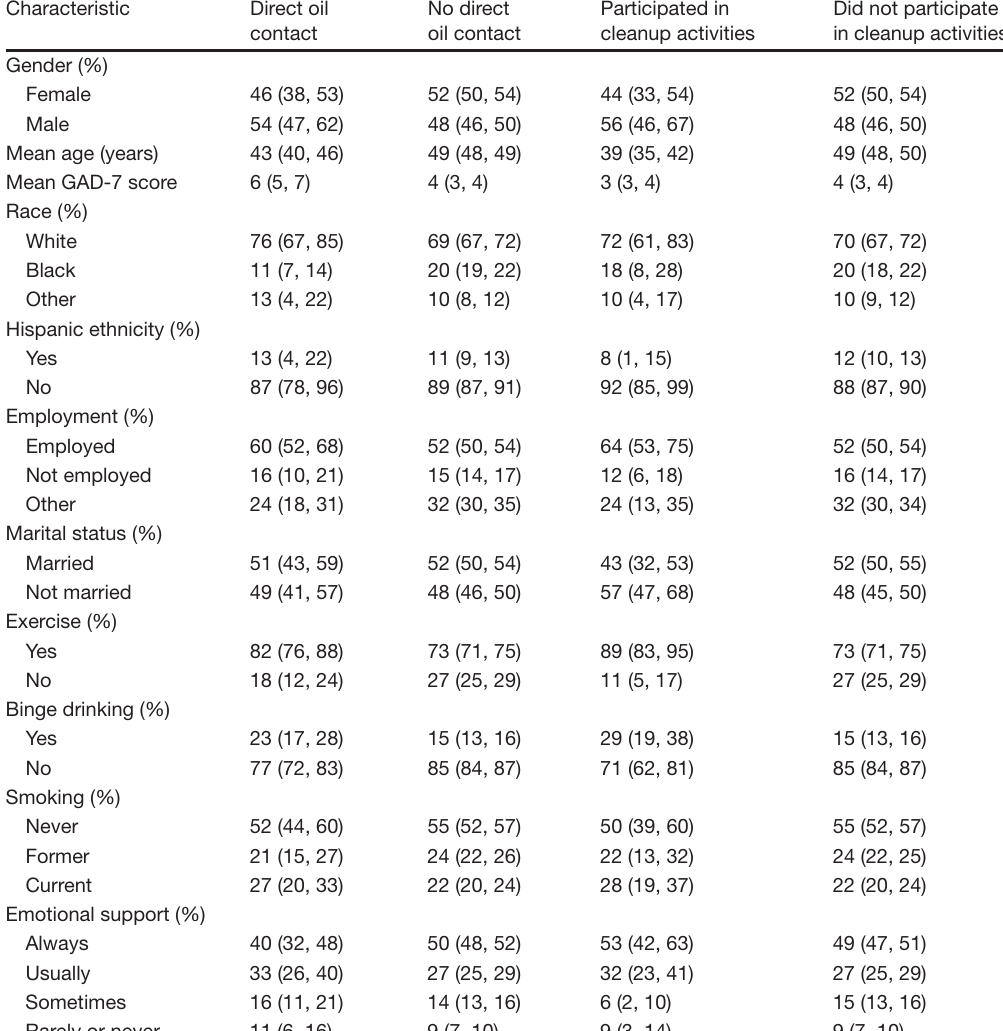
Table 1. Estimated characteristics (point estimates and 95% CI) of the population according to direct oil contact and participation in cleanup activities during the Deepwater Horizon oil spill. These estimates incorporate MI and survey estimation for population inference